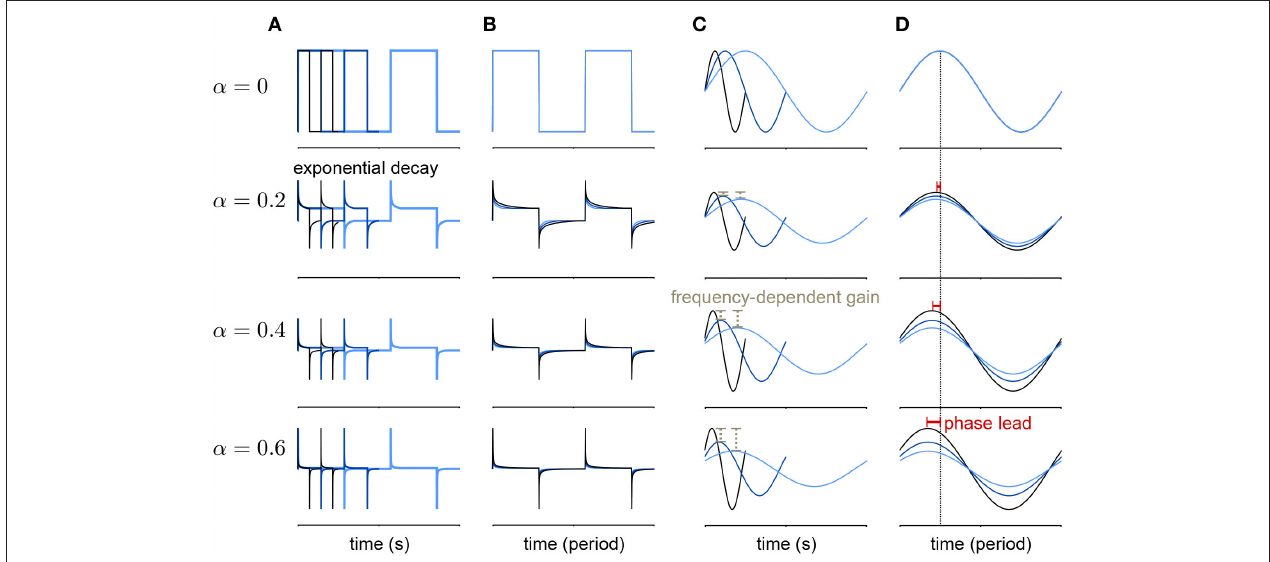
FIGURE 2 | Example of a fractional derivative of several orders. Each row shows a different fractional order ( α ) of the function in the top row. (A) The fractional derivatives of a step function with three different periods (colors) shows exponential filtering with an α dependent timescale. (B) The fractional derivatives in A scaled by period. (C) The fractional derivatives of a sine function for three different periods. As α increases, the fractional derivative shows greater frequency-dependent gain. (D) The same function as in (B) with the sine functions scaled by period. At higher orders, the phase lead of the fractional derivative relative to the signal increases equally over